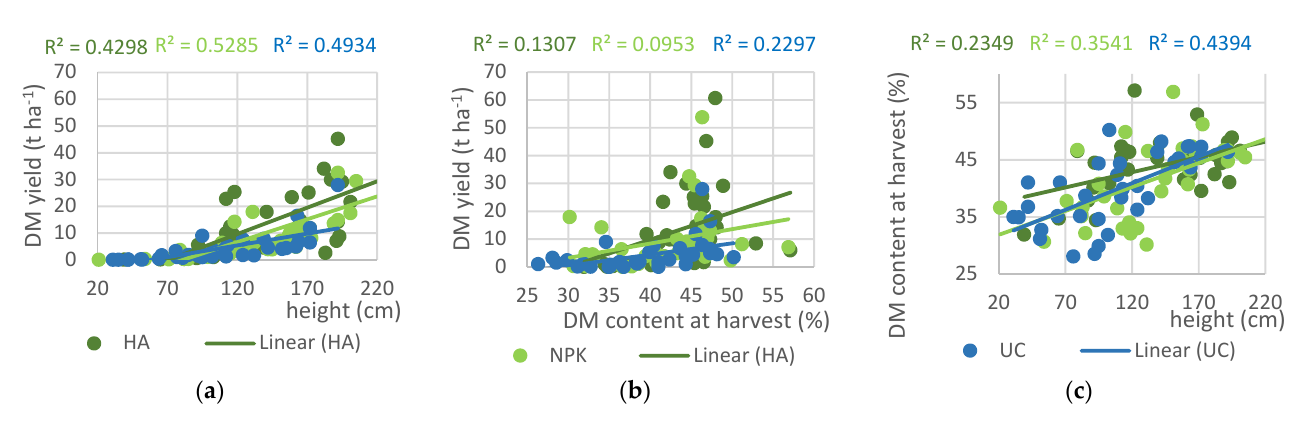
( f ) Figure 5. The linear course of dependence of dry ma tt er yield on crop height ( a – c ) and dry ma tt er content at harvest on crop height ( d – f ) according to treatments HA ( a , d ), NPK ( b , e ), and UC ( c , f ).